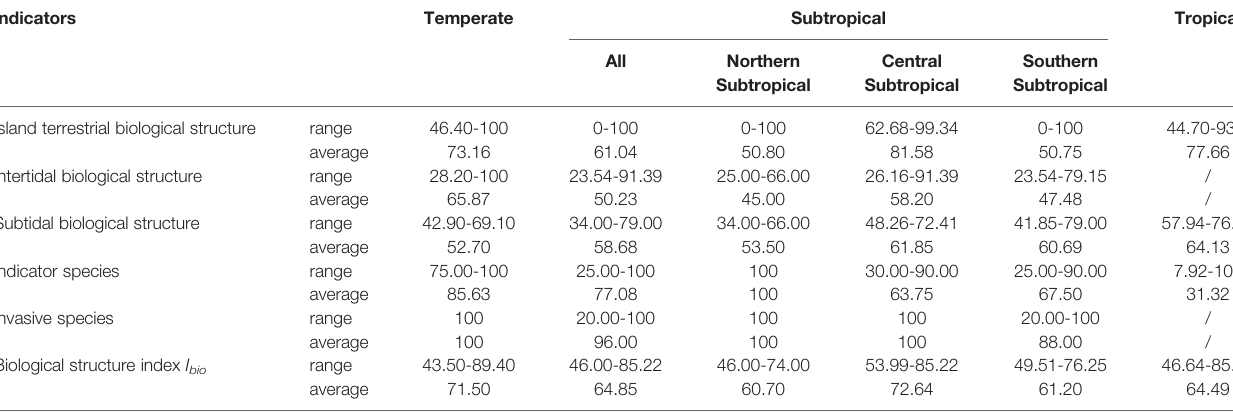
TABLE 5 | Biological structure assessment scores.